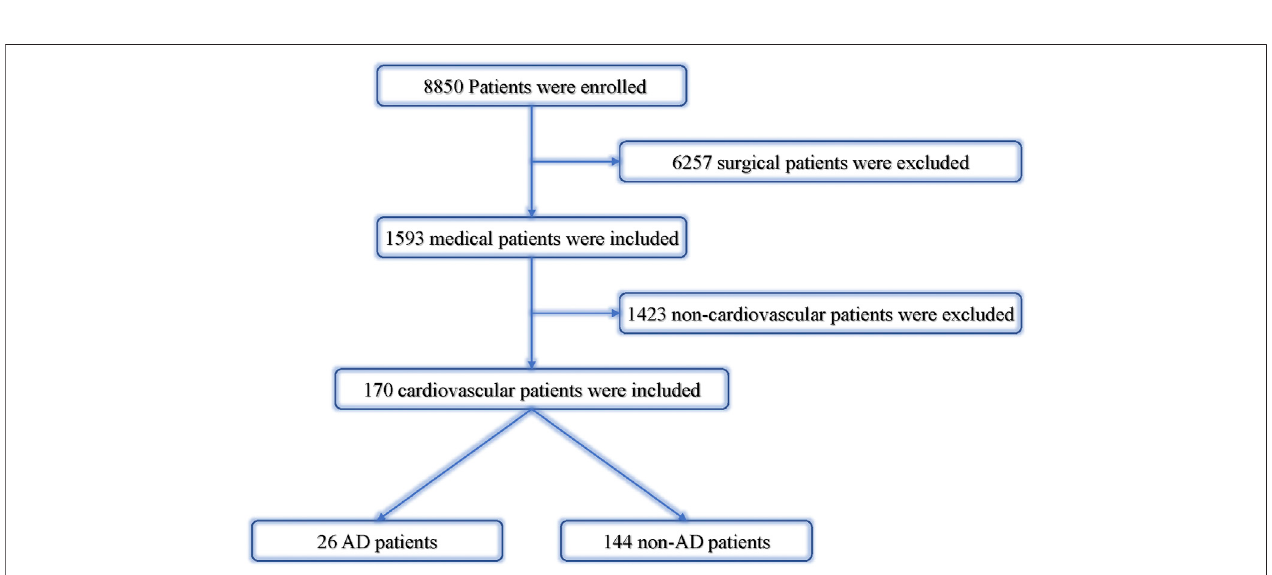
FIGURE 2 | Analysis of cardiovascular dispute cases. AD, aortic dissection; non-AD, without aortic dissection.